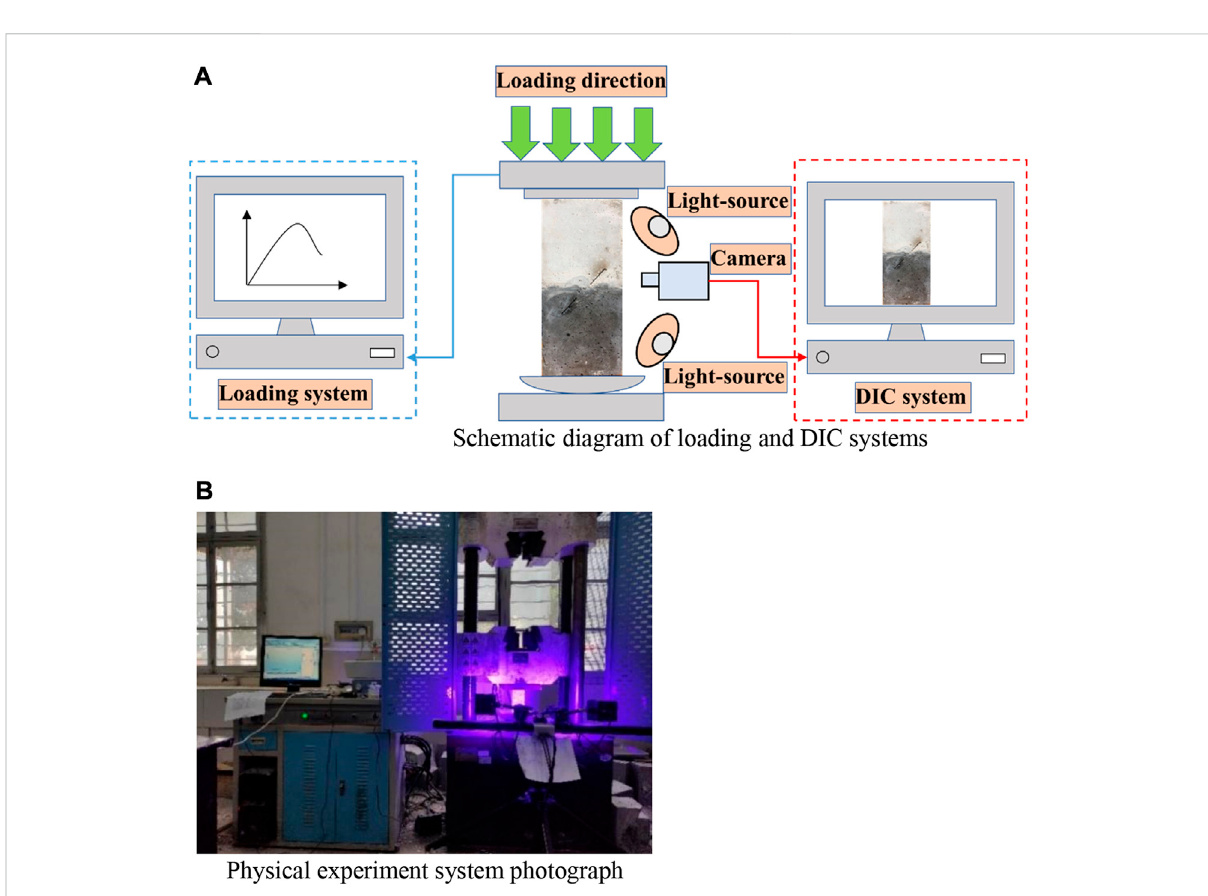
FIGURE 3 Schematic of testing system. (A) Schematic diagram of loading and DIC systems. (B) Physical experiment system photograph.